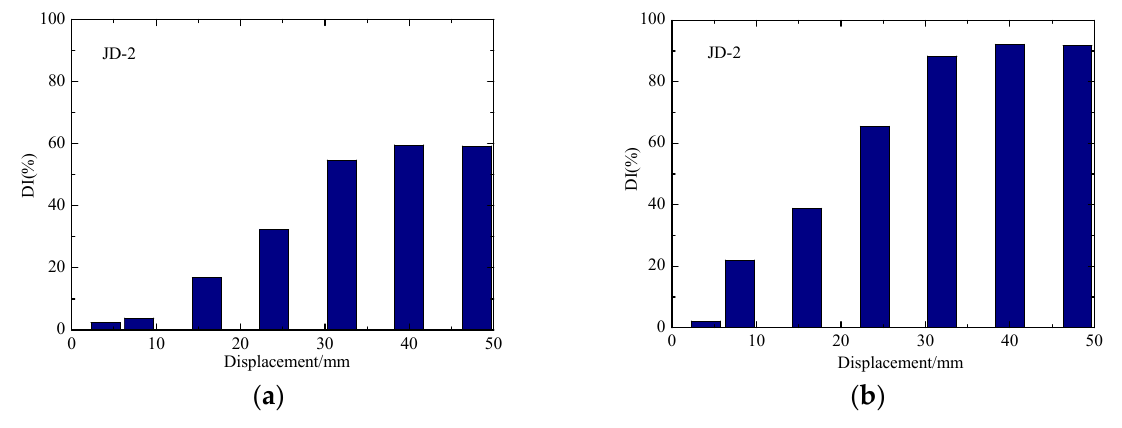
Figure 16. The damage indices of JD-2. ( a ) S1-S2; ( b ) S1-S3.